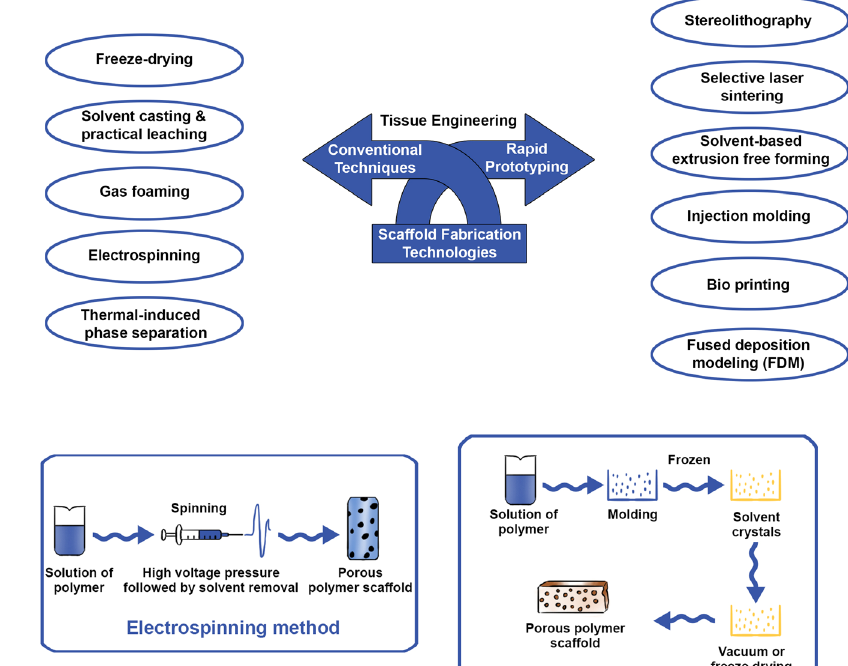
Fig. 3 Classi fi cation of scaffold